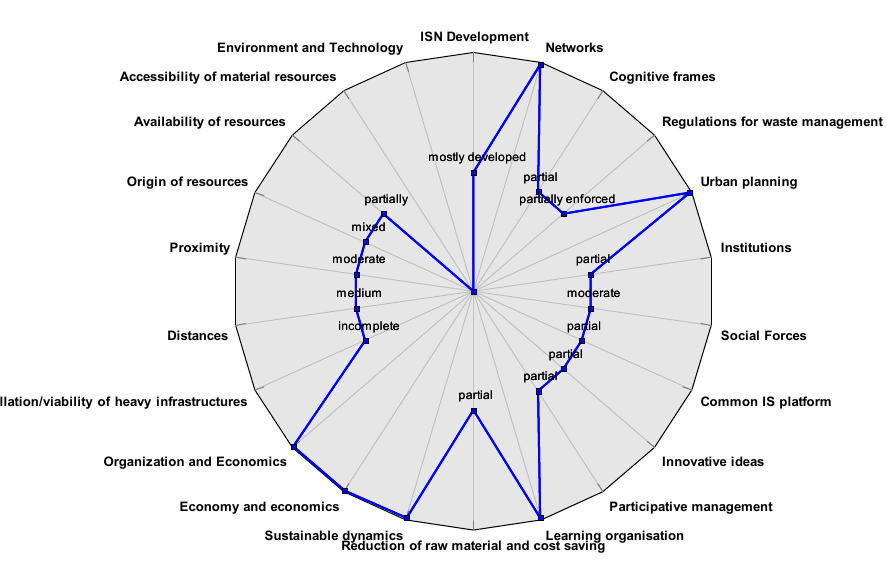
Figure 4. Polar chart of the selected attributes for ISN in Guayama.